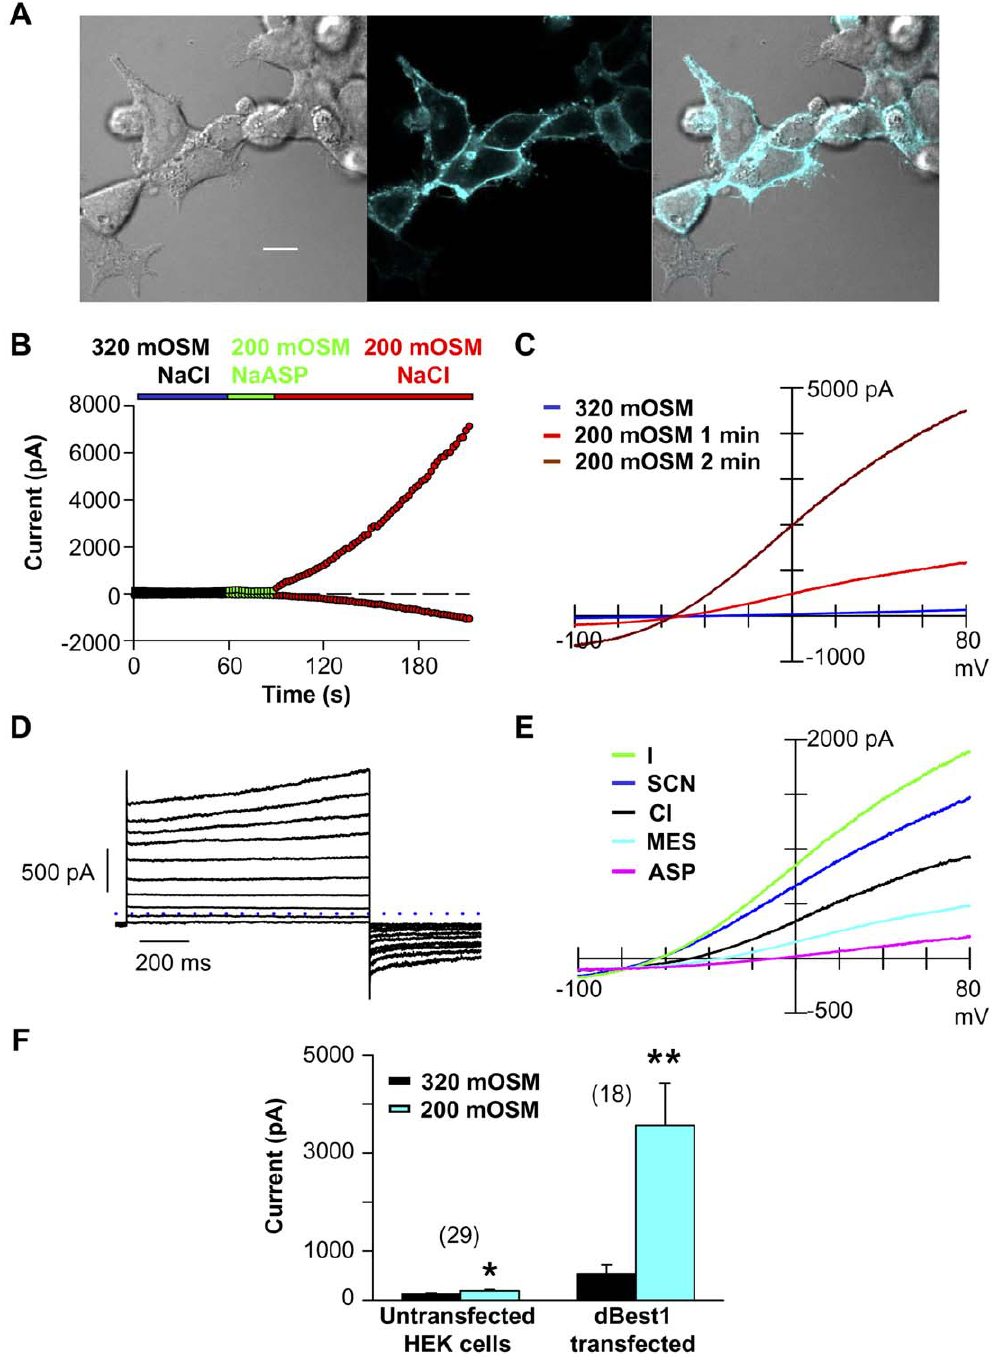
Figure 7. dBest1 overexpression in HEK cells produces a S2R + cell-like I Clswell . ( A ) dBest1-gfp targets to the membrane of HEK cells. Confocal images of dBest1-gfp overexpressed in HEK-293 cells. The DIC image is on the left, GFP in the middle, overlapped images on the right. Scale bar indicates 10 m m. ( B ) I dBest1 rapidly develops within the first 2 min of hypo-osmotic stimulation. ( C ) The developing I dBest1 has the same ‘‘S’’ shape rectification as the endogenous S2R + cell I Clswell . ( D ) Step protocol shows that I dBest1 shares time-dependent activation and tail current properties with S2R + cell I Clswell . ( E ) The constitutively active I dBest1 and S2R + cell I Clswell selectivity sequences are very similar. ( F ) I dBest1 is clearly separable from the endogenous HEK cell I Clswell . I dBest1 increases 15.8 fold 6 4.5 (n=18; ** paired Student’s t-test, p , 0.005) in the first 2 min of hypo-osmotic stimulation; the endogenous HEK cell I Clswell increases 2.1 fold 6 0.4 (n=29; * paired Student’s t-test, p , 0.05). doi:10.1371/journal.pone.0046865.g007 anion-sensitive fluorescent protein to assign molecular identity to a We found that the RNAi effectiveness was essential for Cl swell chloride channel. Our screen supports the findings of the Hartzell candidate identification. Two separate dBest1-targeting RNAi’s lab [15]: dBest1 RNAi eliminates Drosophila I Clswell . were part of our initial screen: DRSC26457 and DRSC16909